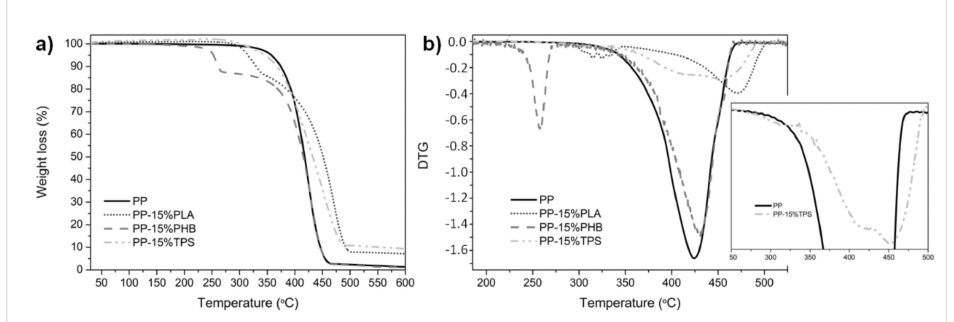
Figure 3. ( a ) TGA and ( b ) DTG thermograms of PP blends with 15 wt.% of biodegradable